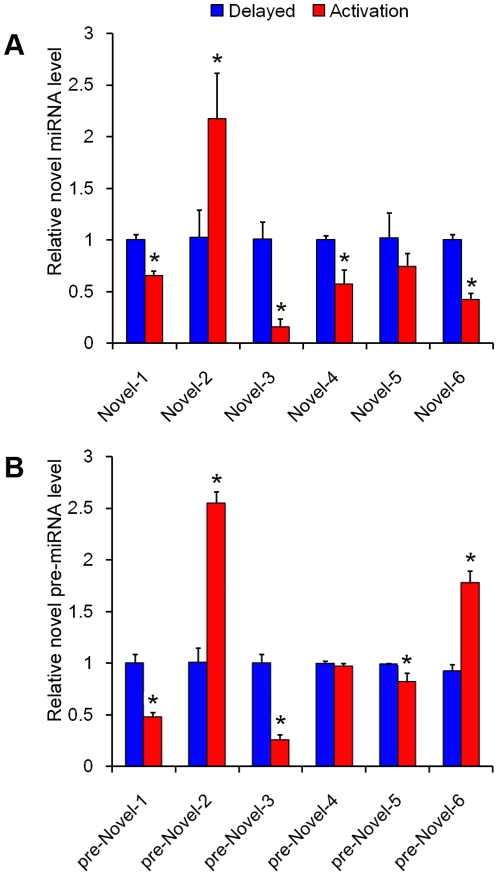
Prediction and confirmation of the novel miRNAs.(A) qRT-PCR of mature miRNAs; (B) qRT-PCR of precursor miRNAs.